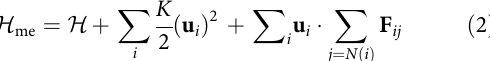
NATURE COMMUNICATIONS|7:12592|DOI: